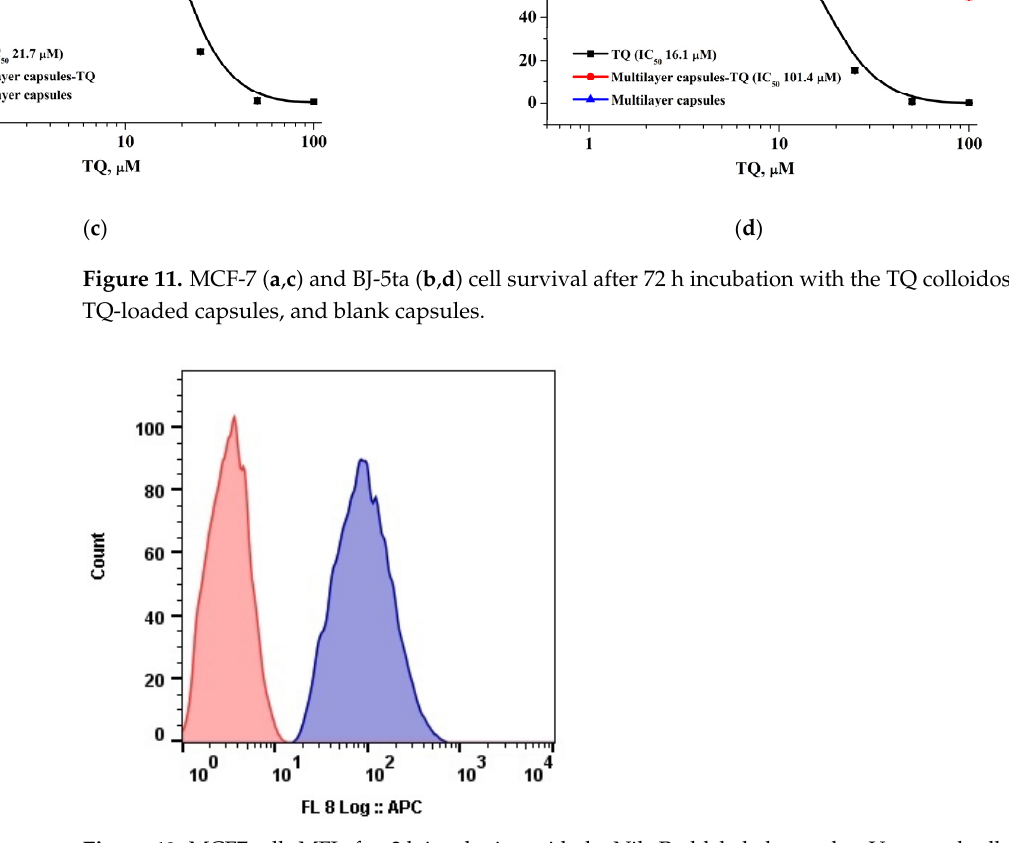
Figure 11. MCF-7 ( a , c ) and BJ-5ta ( b , d ) cell survival after 72 h incubation with the TQ colloidosomes, TQ-loaded capsules, and blank capsules.